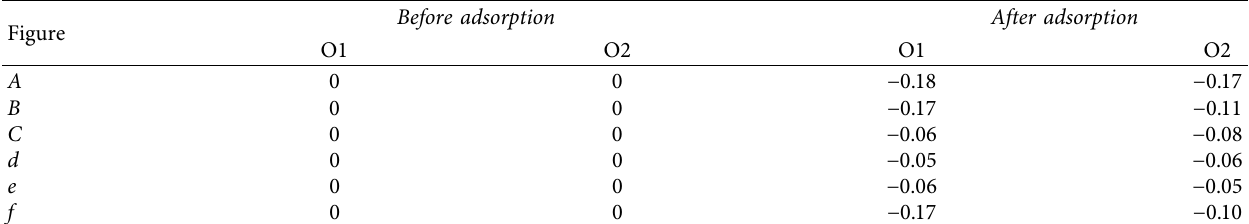
Table 1: Mulliken atomic population values of O atoms before and after